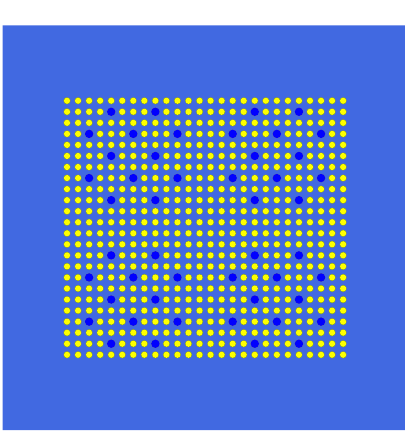
Figure 2: LEU-COMP-THERM-046 Case 01